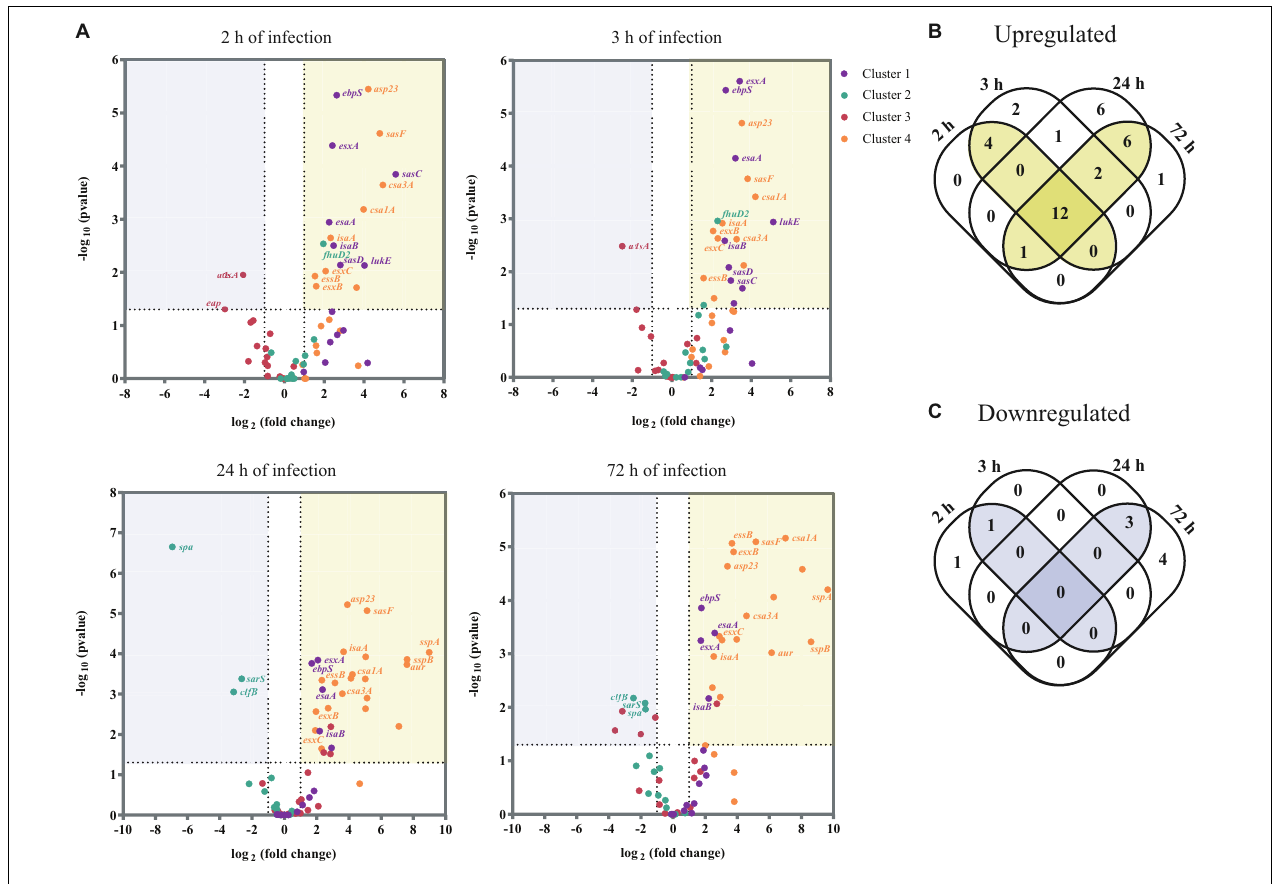
FIGURE 3 | USA300 virulence factors differentially expressed during ex vivo skin infection when compared with inoculated bacteria. (A) Volcano plot showing the transcripts that are significantly downregulated ( ≥ 2-fold decrease, P < 0.05) or upregulated ( ≥ 2-fold increase, P < 0.05) for each time point (2, 3, 24, and 72 h of infection). Data were normalized over the inoculated bacteria and are expressed in log 2 (fold change). The results are shown as the mean of three independent experiments. For each assay, statistical analysis was performed by one-way ANOVA, with Tukey’s multiple comparison tests. (B,C) Venn diagram showing the number of virulence factors that are upregulated (B) and downregulated (C) per time